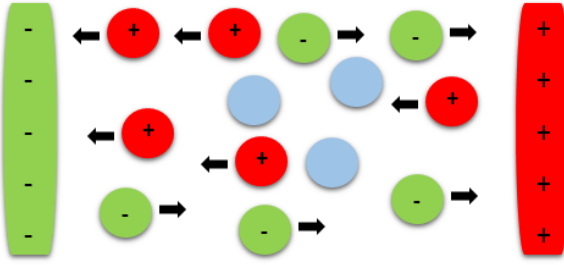
Figure 1. Anions (green) with a negative charge get attracted to- ward the positively charged electrode; cations (red) with a positive charge get attracted toward the negatively charged electrode. Neu- tral molecules (blue) remain without any electrical